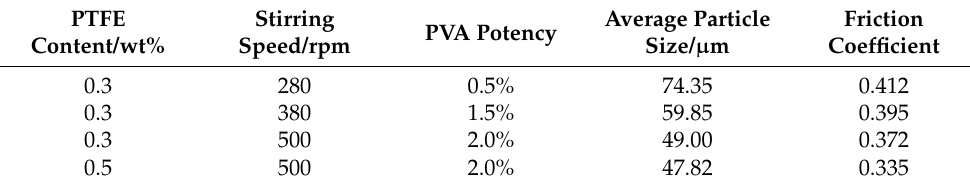
Table 1. The effect of particle size on the friction coefficient of PTFE/PS. PTFE Con-